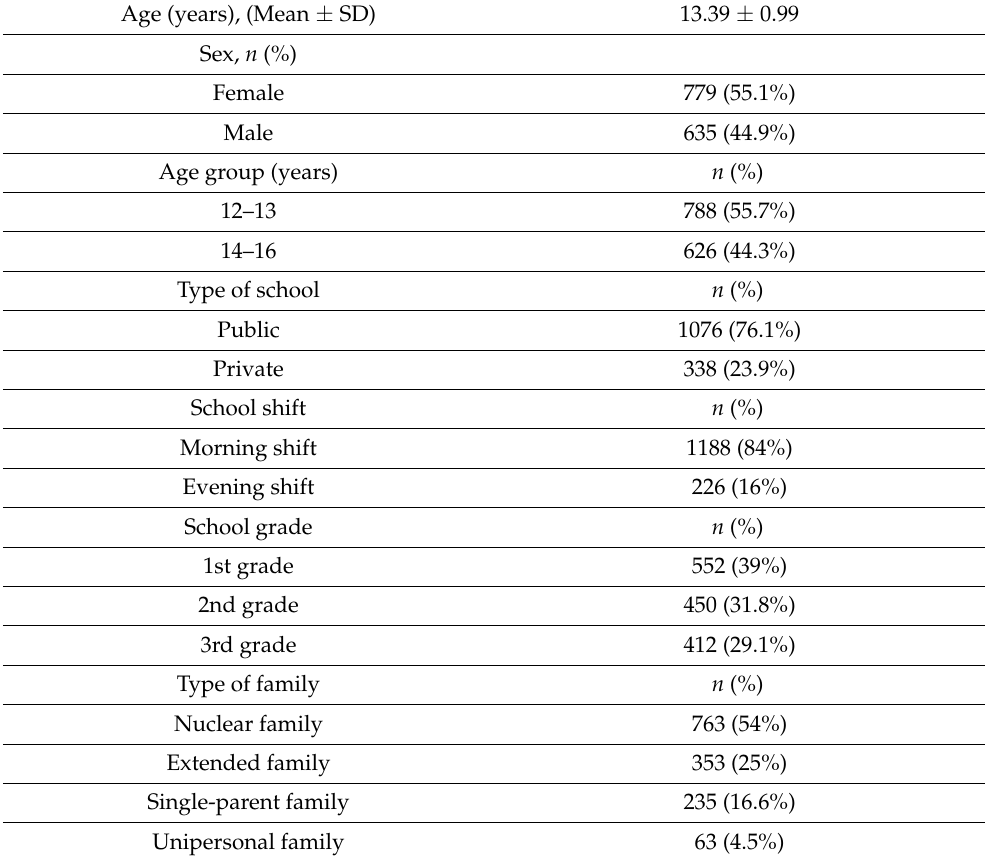
Table 2. Demographic characteristics of the